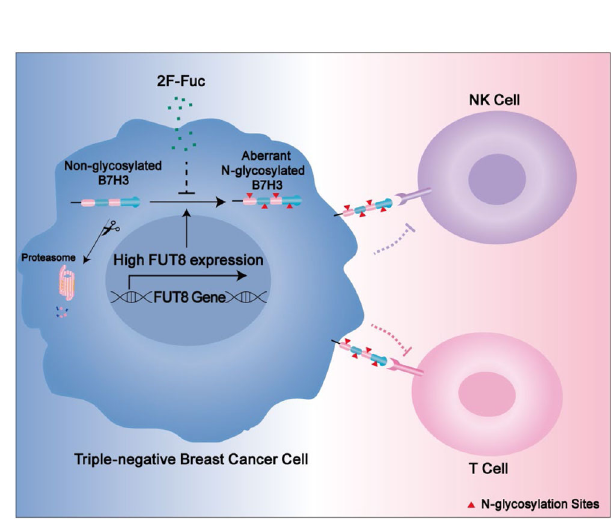
Fig. 9 Proposed model of resistance to immune response through FUT8- mediated aberrant N-glycosylation of B7H3 in TNBC cells. In TNBC cells, FUT8 catalyzes aberrant B7H3 core fucosylation at N-linked oligosaccharides, which is essential for B7H3 stability and expression on the cell surface, resulting in the resistance of tumor cells to immune attack. Inhibition of B7H3 core fucosylation by 2F-Fuc reduces cell-surface expression of B7H3 and enhances T-cell activation, leading to more ef fi cient tumor